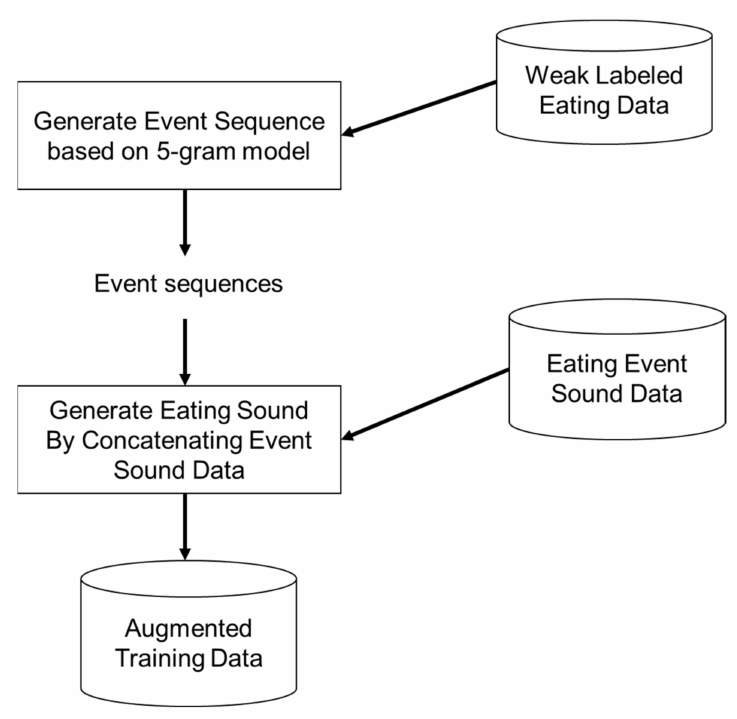
Figure 8. Data augmentation by concatenating eating event sound